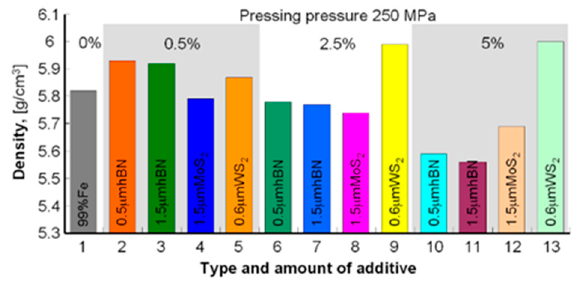
Figure 3. Sample densities after pressing 250 MPa and sintering.